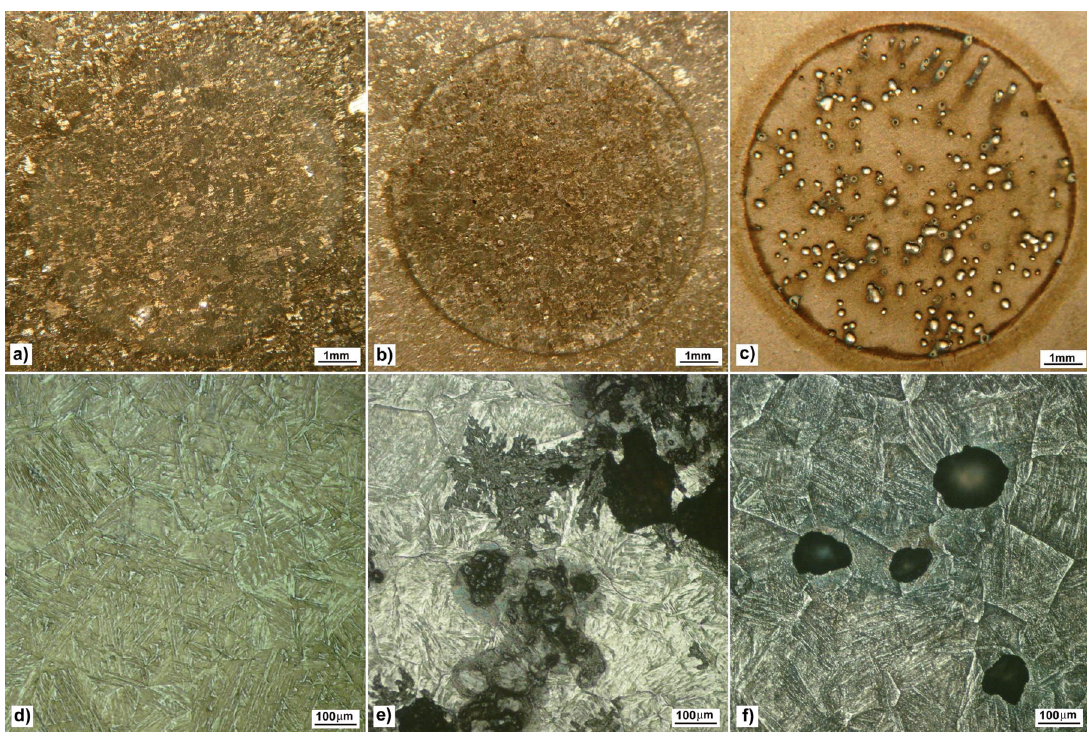
Figure 5. Light optical micrographs from the corroded region of plasma nitrided SMSS at (a, d) 400°C, (b, e) 450°C and (c, f) 500°C after potentiodynamic polarization in 3.5% NaCl solution